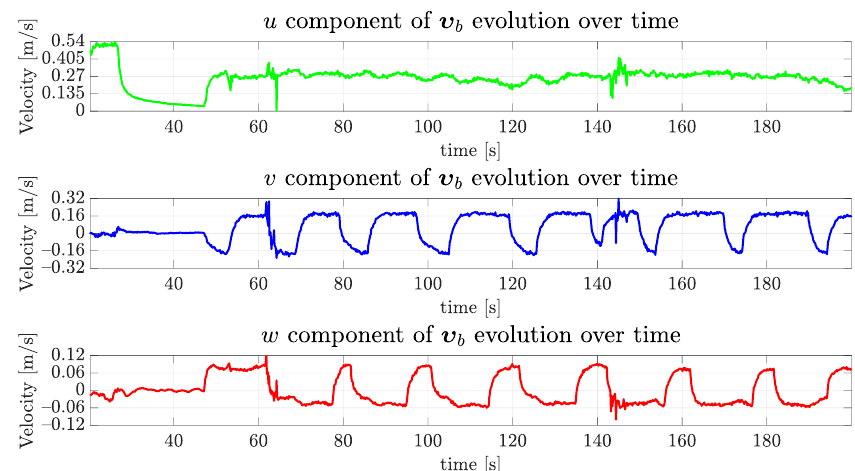
Figure 26. The evolution of linear velocities components of VITA1 over time for the real